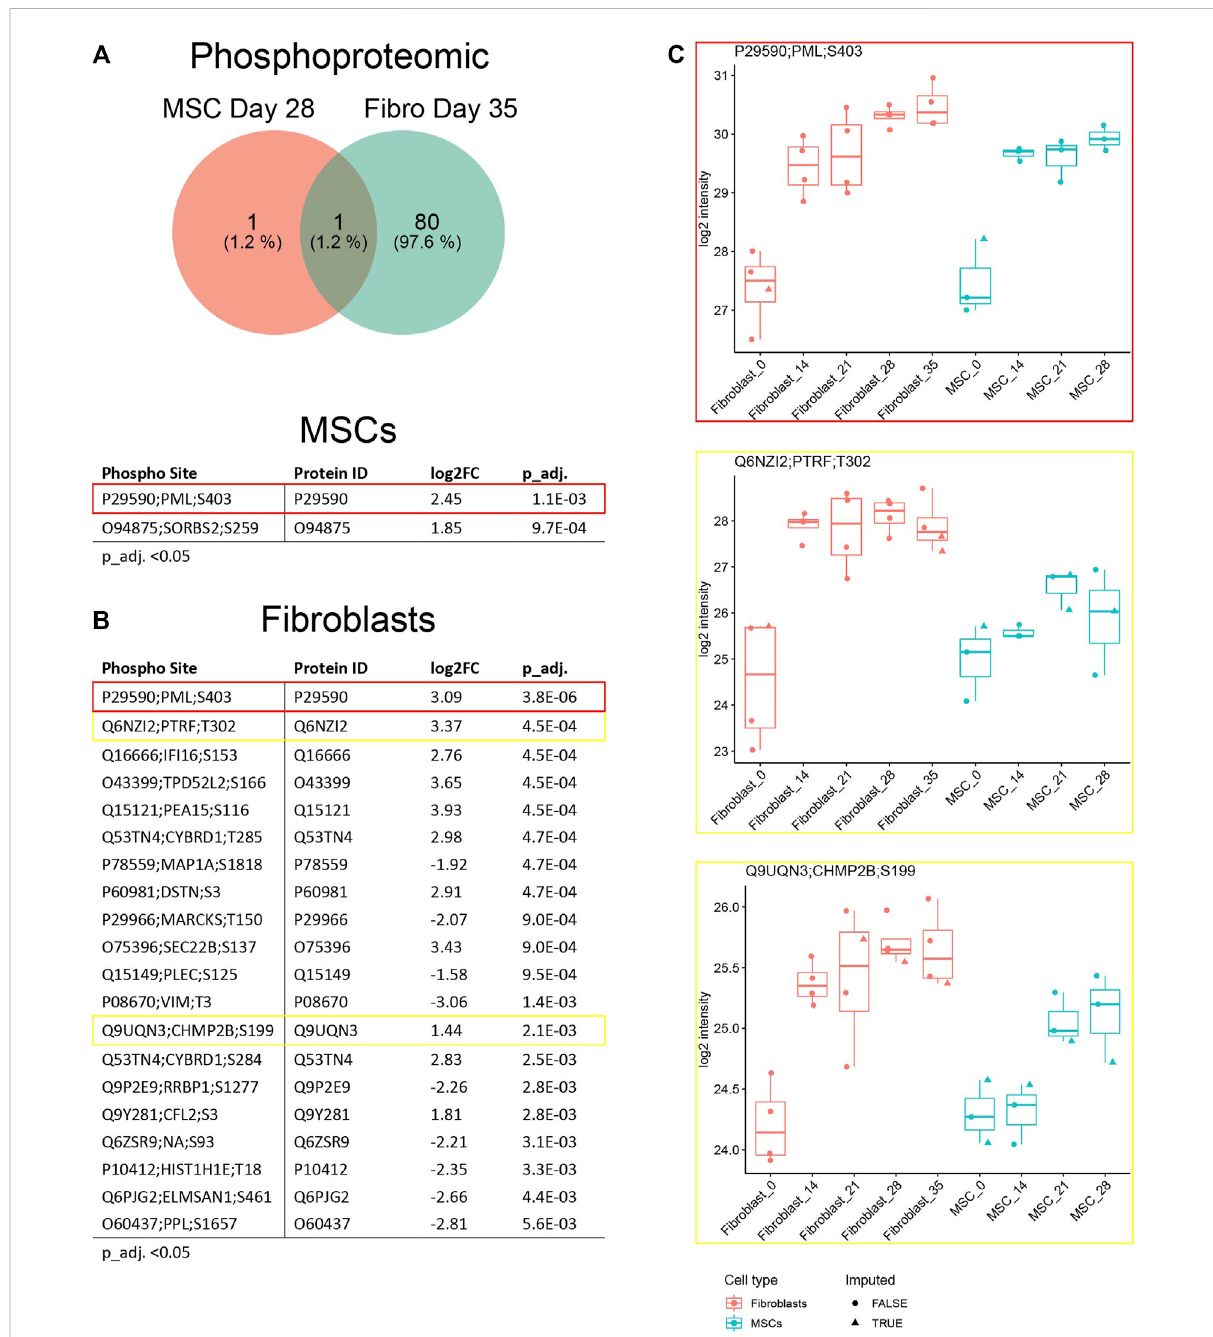
FIGURE 7 Phosphoproteomic pro fi les in fi broblasts and MSCs induced by osteoblastic differentiation. (A) Total number of differentially expressed phosphorylated proteinsitesin fi broblasts and MSCs, undifferentiated state versus differentiatedstate. One phosphorylated protein included in both cell types, one exclusively in MSCs and 80 exclusively in fi broblasts. (B) Top 20 most differentially expressed phosphorylated proteins in MSCs and fi broblasts comparing undifferentiated state to last time point, p_adj. < 0.05 (Benjamini – Hochberg FDR adjustment) (C) Hyperphosphorylation of PML (marked in red), PTRF (yellow) and CHMP2B (yellow) during the osteoblastic differentiation in both cell types. Box plots of intensity values of thedifferentlyexpressedphosphoproteins(p_adj. <